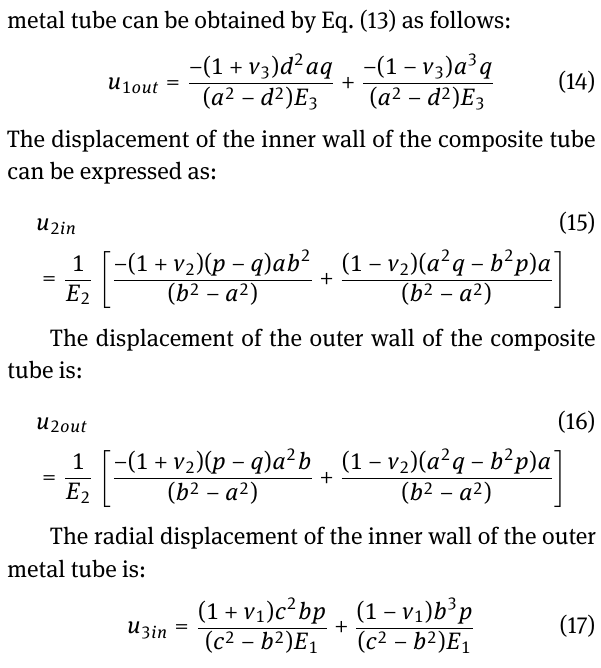
its outer wall caused by the radial constraint of the outer metaltube.Correspondingly,thepressure q willbeexerted on the inner wall of the outer metal tube and pressure p will be exerted on the outer wall of the inner metal tube (Figure 3). The pressure p and q are the preload of the